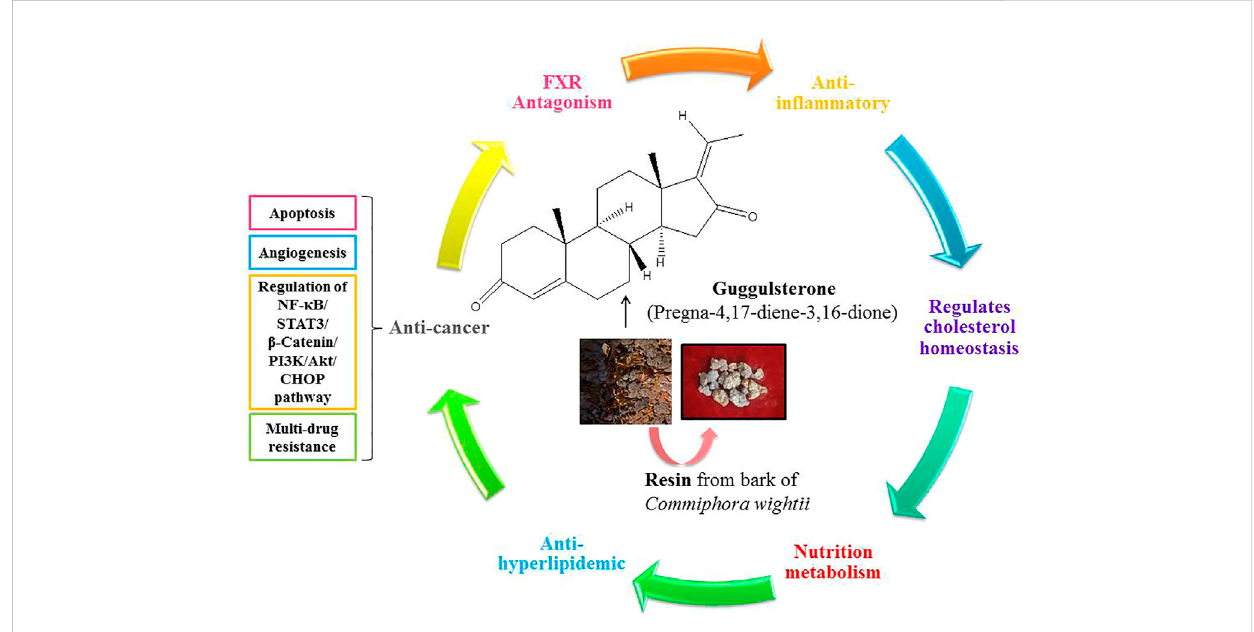
FIGURE 1 Schematic representation of the pleiotropic effects of Guggulsterone.